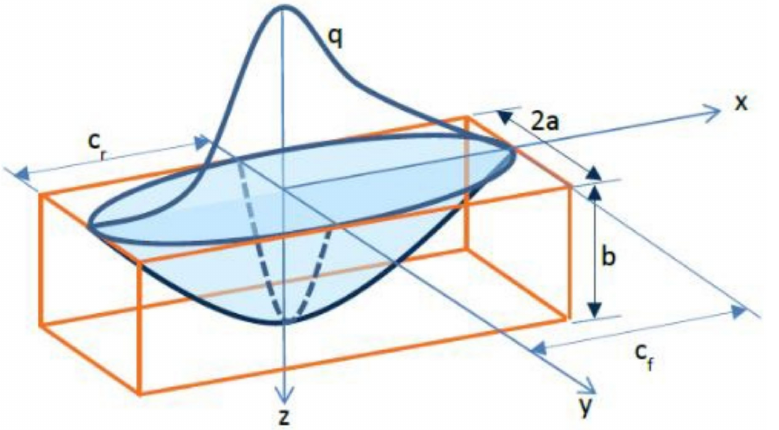
Figure 1. Representation of Goldak double ellipsoidal heat source (Dassault Syst è mes, V é lizy-Villacoublay,